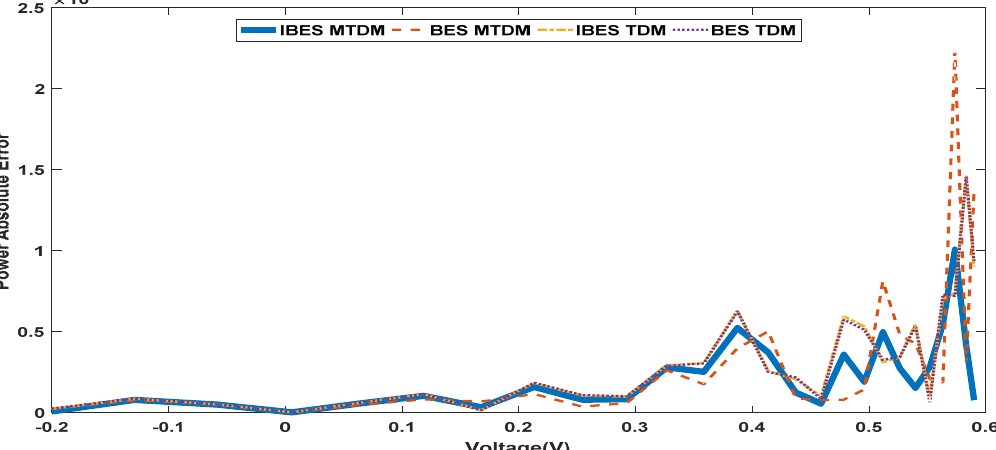
Figure 17. PAE for the IBES and BES for all cases.